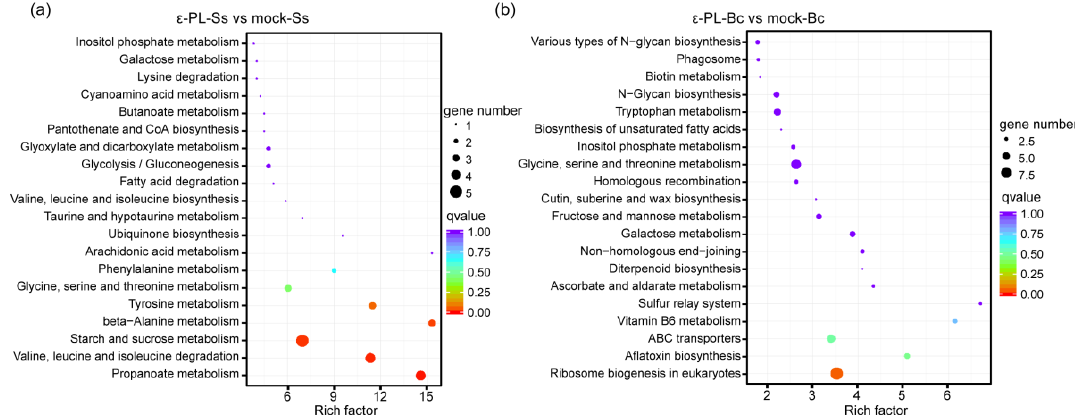
Figure 5. Kyoto Encyclopedia of Genes and Genomes (KEGG) pathways of the enriched DEGs of ( a ) ε -PL-Ss vs. mock-Ss and ( b ) ε -PL-Bc vs. mock-Bc. The rich factor reflects the degree of enriched DEGs in a given pathway. The number of enriched DEGs in the pathway is shown by the circle area, and the circle color represents the ranges of the corrected p -value.